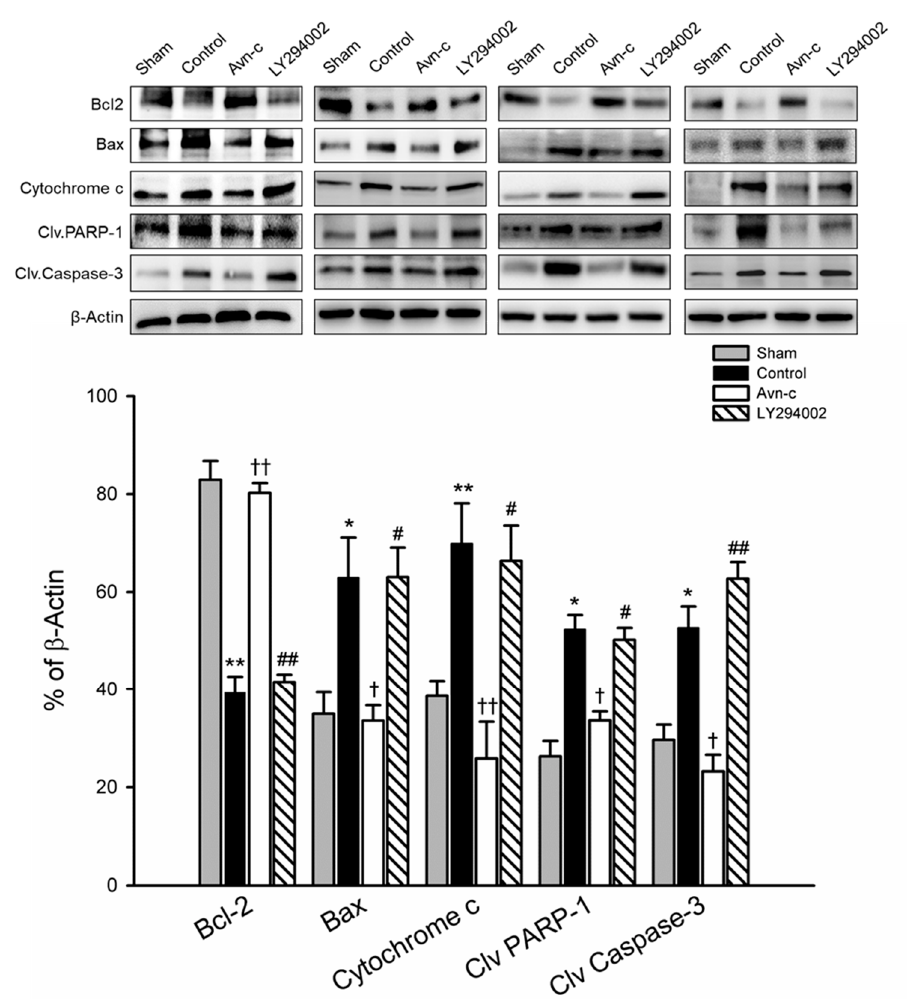
Figure 4. Avn-c exhibits anti-apoptotic effect in MCAo mice. Western blot analysis for the expression of Bcl-2, Bax, Cytochrome c, Cleaved PARP-1 and Cleaved caspase-3. Quantitative analysis of Bcl2, Bax, Cytochrome c, Cleaved PARP-1 and Cleaved caspase-3 expression. Data shown are mean ± SEM (data from 16 mice, n = 4). * p < 0.05 and ** p < 0.01 vs. Sham group. † p < 0.05 and †† p < 0.01 vs. Control group. # p < 0.05, ## p < 0.01 vs. Avn-c group.